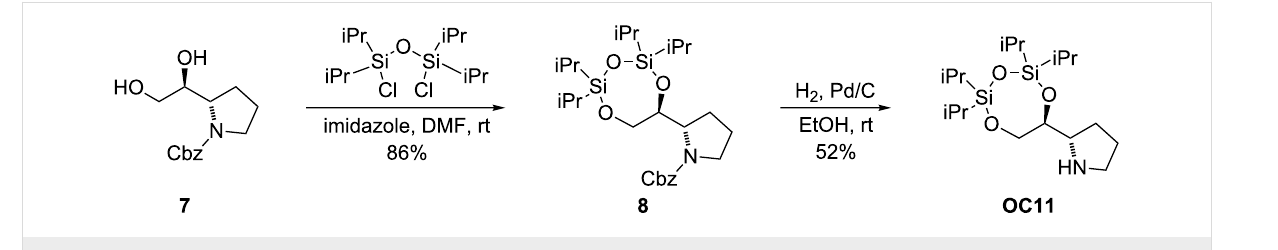
Scheme 5: Synthesis of new organocatalyst OC11